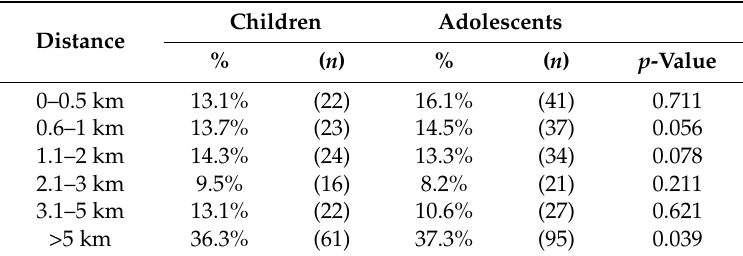
Table 3. Distances from home to school in children and adolescents.